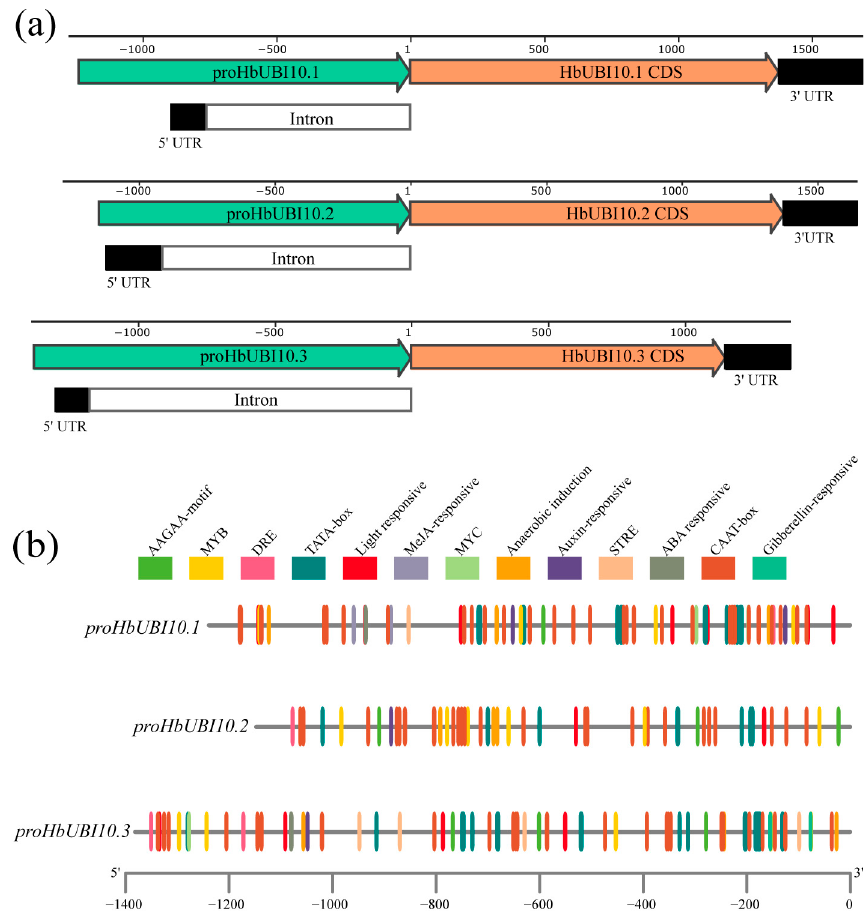
Figure 2. Analysis of three HbUBI genes and their promoters. ( a ) Schematic representation of the genomic structures of three polyubiquitin genes. ( b ) Putative cis -elements identified in these three HbUBI promoter regions. Abbreviations: CDS, coding sequence; UTR, untranslated region; DRE, dehydration-responsive element; MeJA, methyl jasmonic acid; STRE, stress response element; ABA, abscisic acid.